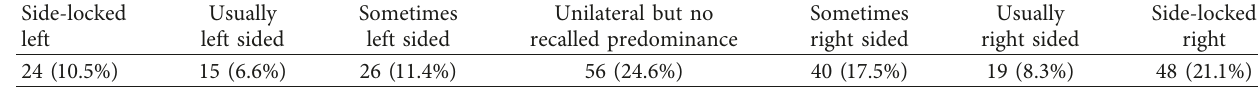
Table 3: Frequency of side experience among migraineurs with lateralized headache ∗ .